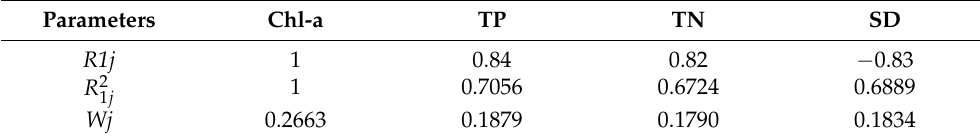
Table 1. The correlation coefficient for Chl-a to other parameters of Chinese lakes and reservoirs. Parameters Chl-a TP TN